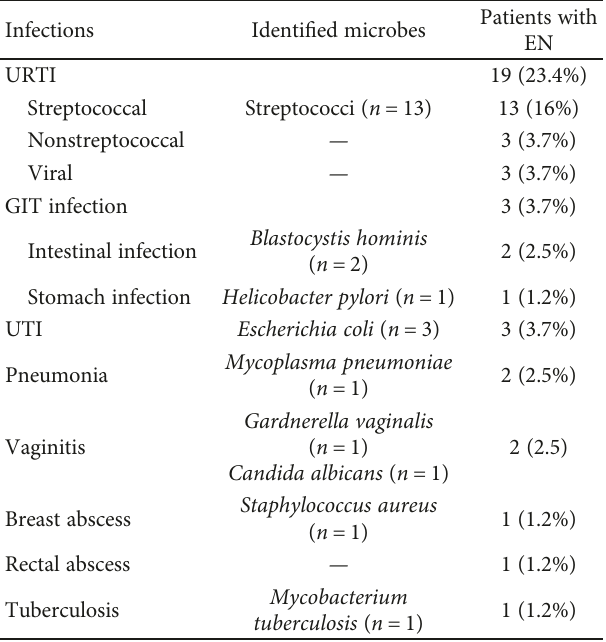
Table 3: Infections and identi fi ed microbes in patients with erythema nodosum ( n = 81